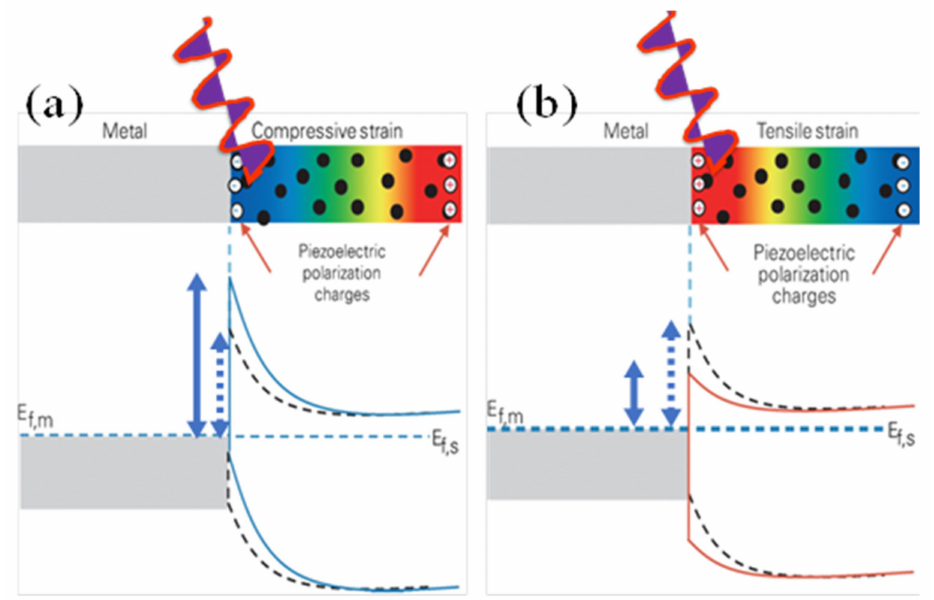
Figure 7. Schematic of energy diagram illustrating the e ff ect of piezopotential on metal-semiconductor interface under illumination with photons of energy greater than the band gap; ( a ) Under compressive strain ( b ) Under tensile strain. The dotted and full double arrows indicate the changes in the SBH before and after the applied stress (piezopotential). The black dots represent the free-charge carriers in the bulk semiconductor. ( a , b ) are adapted with permission from reference